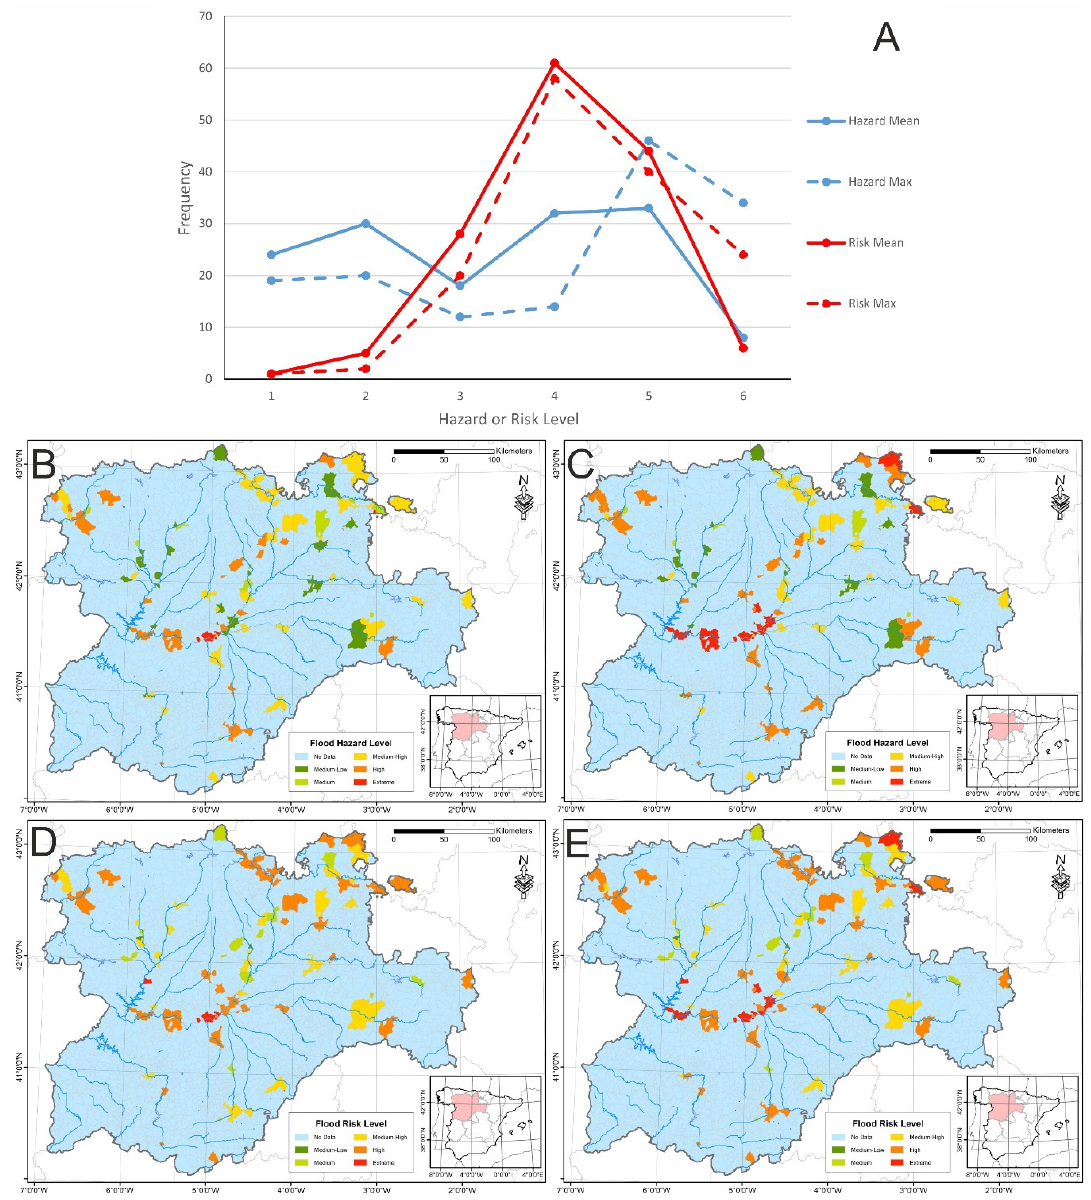
Figure 9. BICs frequency variations ( A ) for flood hazard and flood potential risk upon the use of mean or maximum flood depth values. Flood hazard spatial distribution at municipality level using average ( B ) and maximum ( C ) flow depth data. Potential flood risk spatial distribution at municipality level using average ( D ) and maximum ( E ) flow depth data.